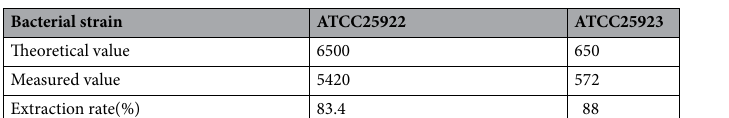
Bacterial strain ATCC25922 ATCC25923 Theoretical value 6500 650 Measured value 5420 572 Extraction rate(%) 83.4 Table 3. Quantitative results of the ddPCR system simultaneously detecting two bacterial strains (bacteria counts of E. coli ∶ bacteria counts of Staphylococcus aureus = 10:1).